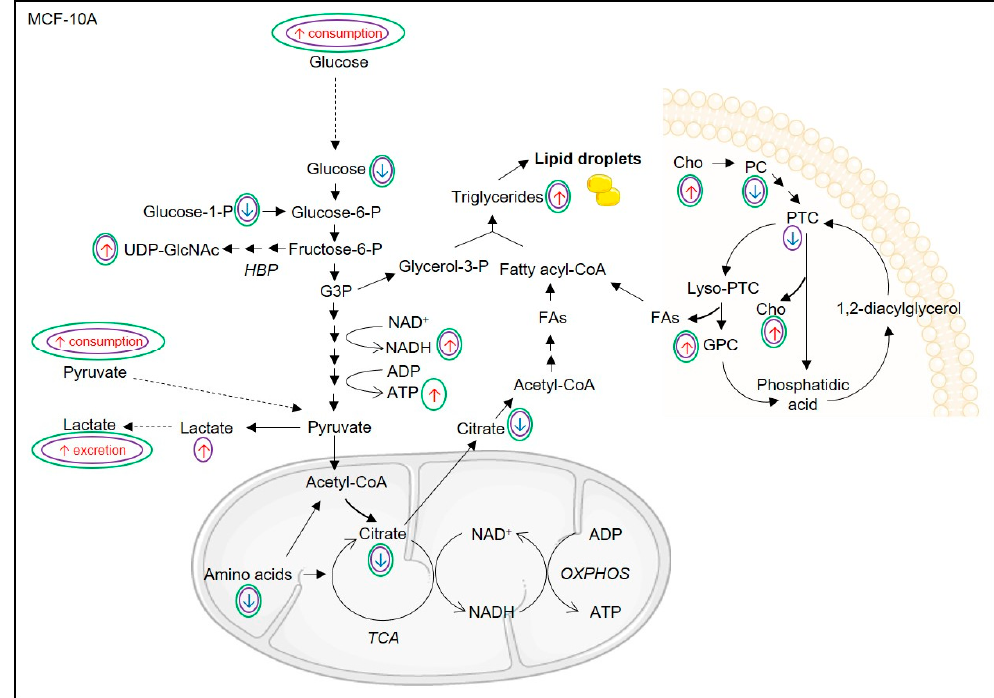
Figure 7. Proposed metabolic reprogramming of MCF-10A breast epithelial cells upon 48 h incubation with BA or UA. Effects of BA and UA are represented by purple and green circles, respectively. ADP/ATP, adenosine di/triphosphate; NAD+/NADH, nicotinamide adenine dinucleotide/reduced form; Cho, choline; PC, phosphocholine; GPC, glycerophosphocholine; PTC, phosphatidylcholine; UDP, uridine diphosphate; UDP-GlcNAc, UDP-N-acetyl-glucosamine; FAs, fatty acids; HBP, hexosamine biosynthetic pathway; TCA, tricarboxylic acid cycle; G3P, glyceraldehyde 3-phosphate; OXPHOS; Oxidative phosphorylation.